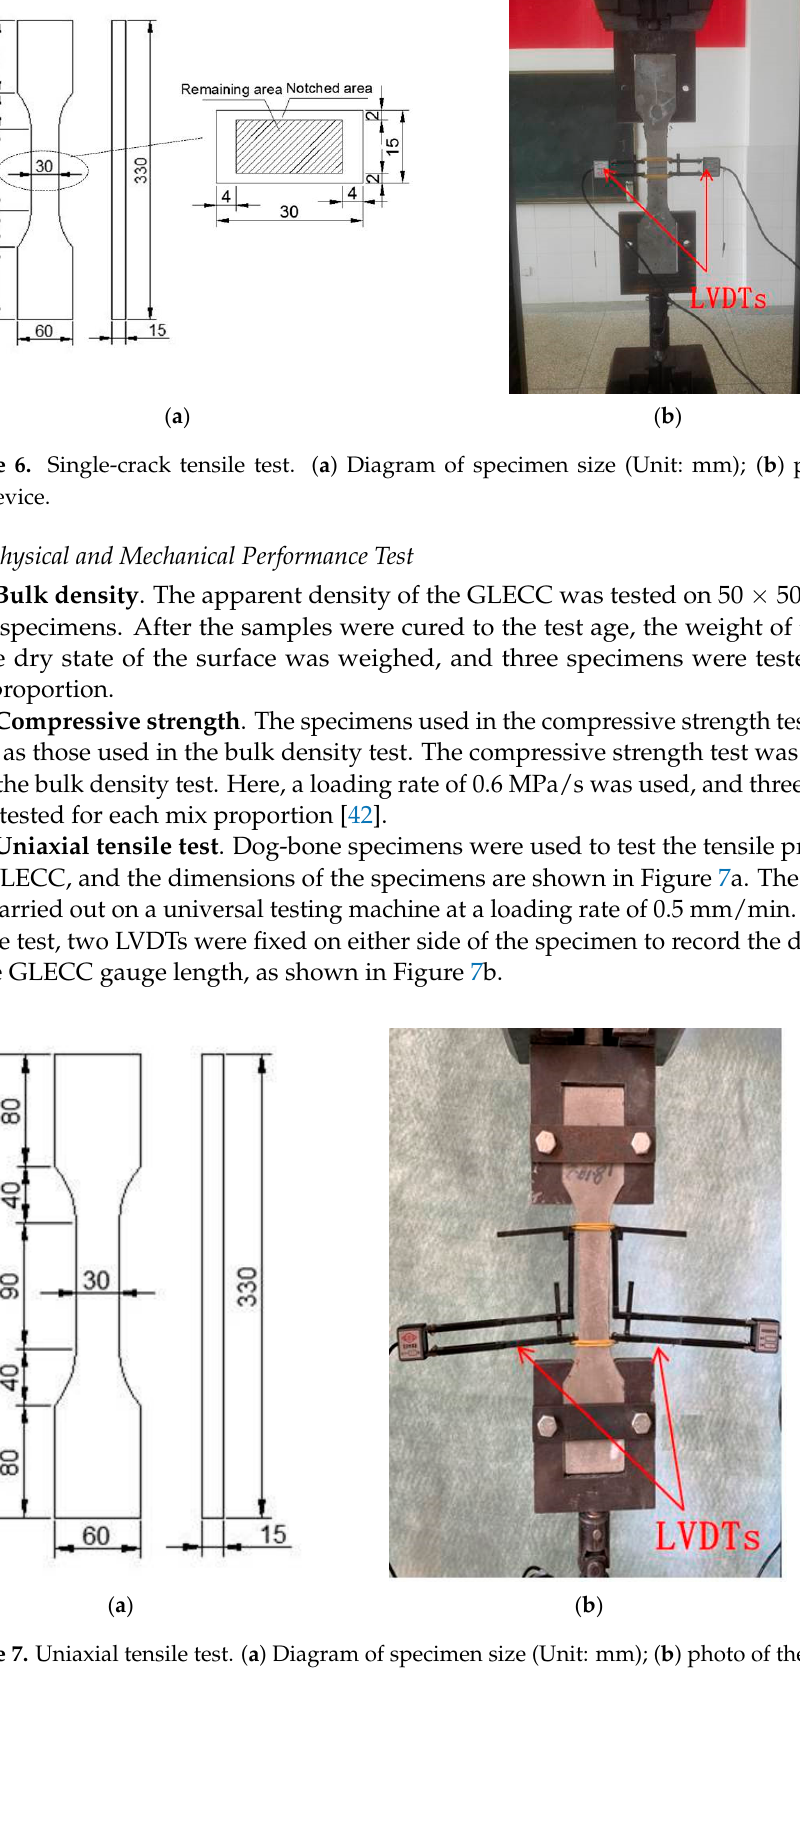
( b ) Figure 5. Fracture toughness test device. ( a ) Photo of the test device; ( b ) diagram of the test device.